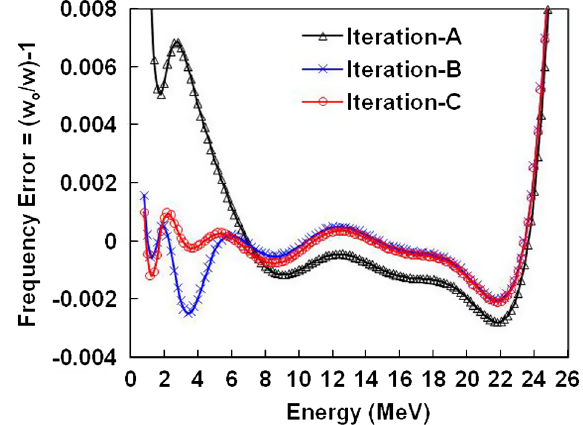
FIG. 8. Average field due to main coils (MC1 and MC2) and the total average field due to all four circular coils and the sector coils. The analytical isochronous field (B_Isoc) is also shown.